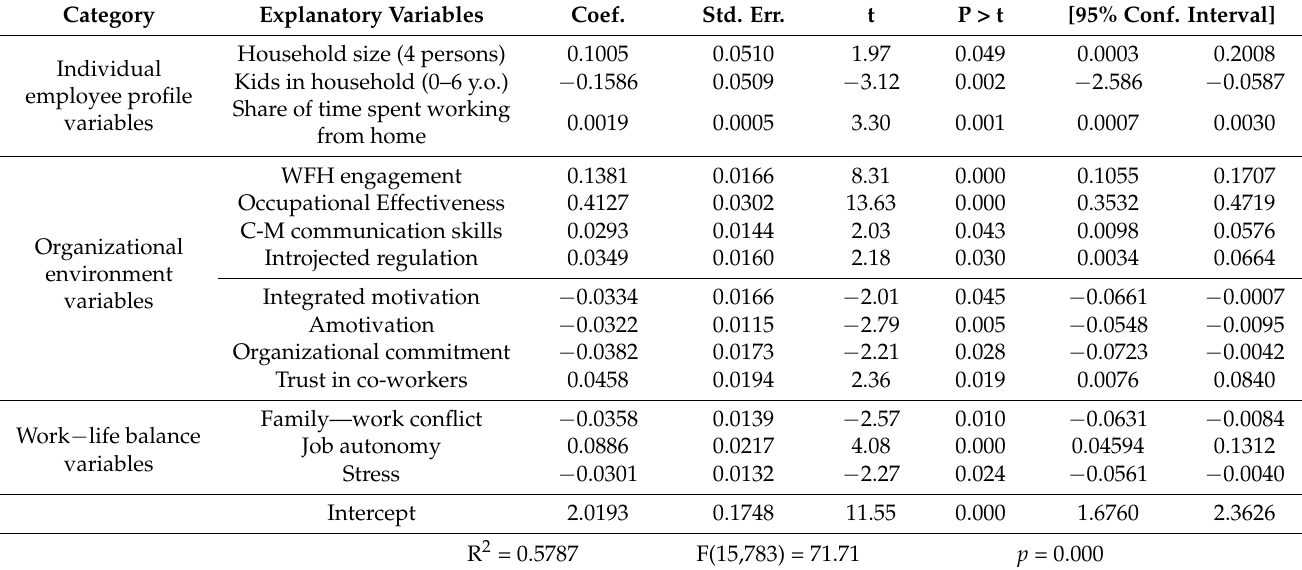
Table 3. Multiple linear regression analysis results related to technical performance—backward